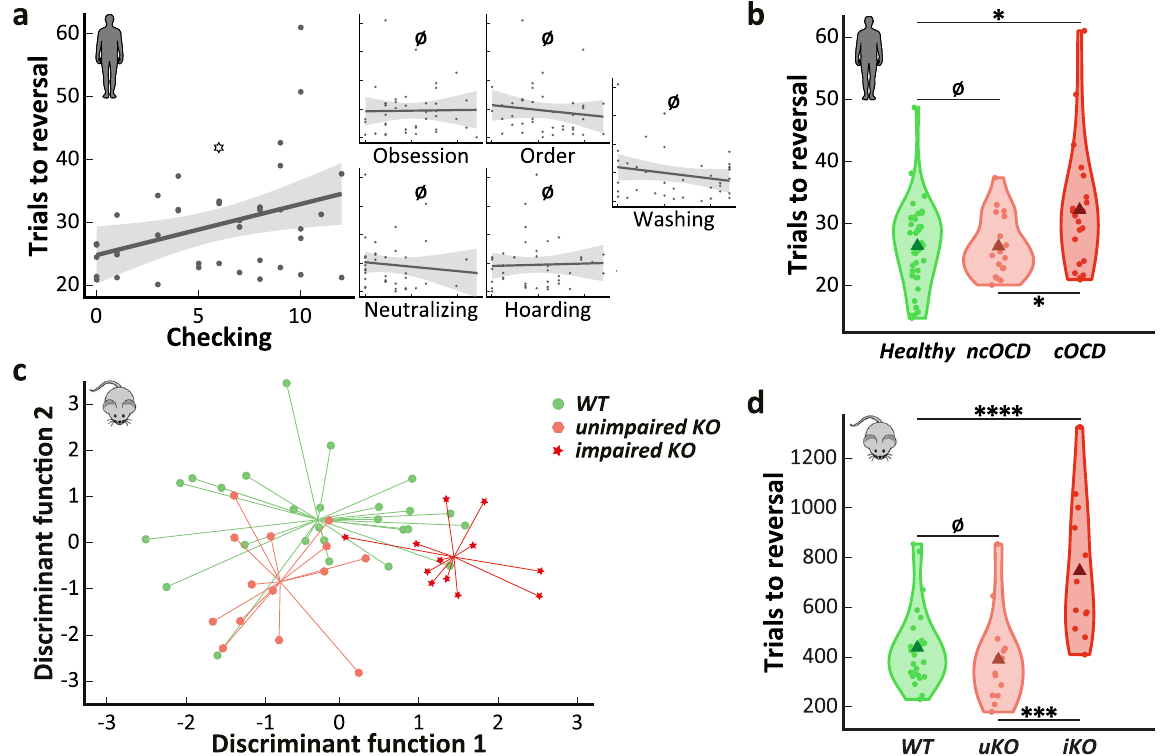
Fig. 3 Only a subgroup of OCD patients and Sapap3 KO mice needed a higher number of trials to reach the reversal criterion. a Only the severity of the checking symptoms (measured by the OCI-R checking subscore) predicts the number of trials needed to reach the reversal criterion. The higher the checking symptoms severity, the higher the number of trials. n = 40 OCD patients. Dark line: linear fi t. Gray area: con fi dence interval. b 21 OCD patients with predominant checking symptoms ( “ checkers ” subgroup, red) were segregated from the others (19 “ non-checkers ” and 40 healthy controls subgroups, pink and green, respectively). Only OCD “ checkers ” patients were impaired in terms of number of trials needed to reach the reversal criterion. ncOCD: “ non-checkers ” . cOCD: “ checkers ” . Triangle: group mean. Dot: individual mean. c A two-step cluster analysis using four behavioral parameters (number of trials to reversal, reversal errors, SSC probability and SSC errors) found two distinct clusters within the Sapap3 KO mice and was con fi rmed by a stepwise discriminant analysis. The intersection point of the lines indicates the group ’ s centroid. d Only the “ impaired ” KO mice ( n = 12, red) needed more trials to reach the reversal criterion compared to the other “ unimpaired ” KO ( n = 14, pink) and WT mice ( n = 26, green). uKO: “ unimpaired ” KO mice. iKO: “ impaired ” KO mice. Triangle: group mean. Dot: individual mean. Ø: BF ≥ 3. **BF ≥ 10. ***BF ≥ 30. ****BF ≥ * BF 10 < 1. 10 < 3. *BF 10 10 10 10